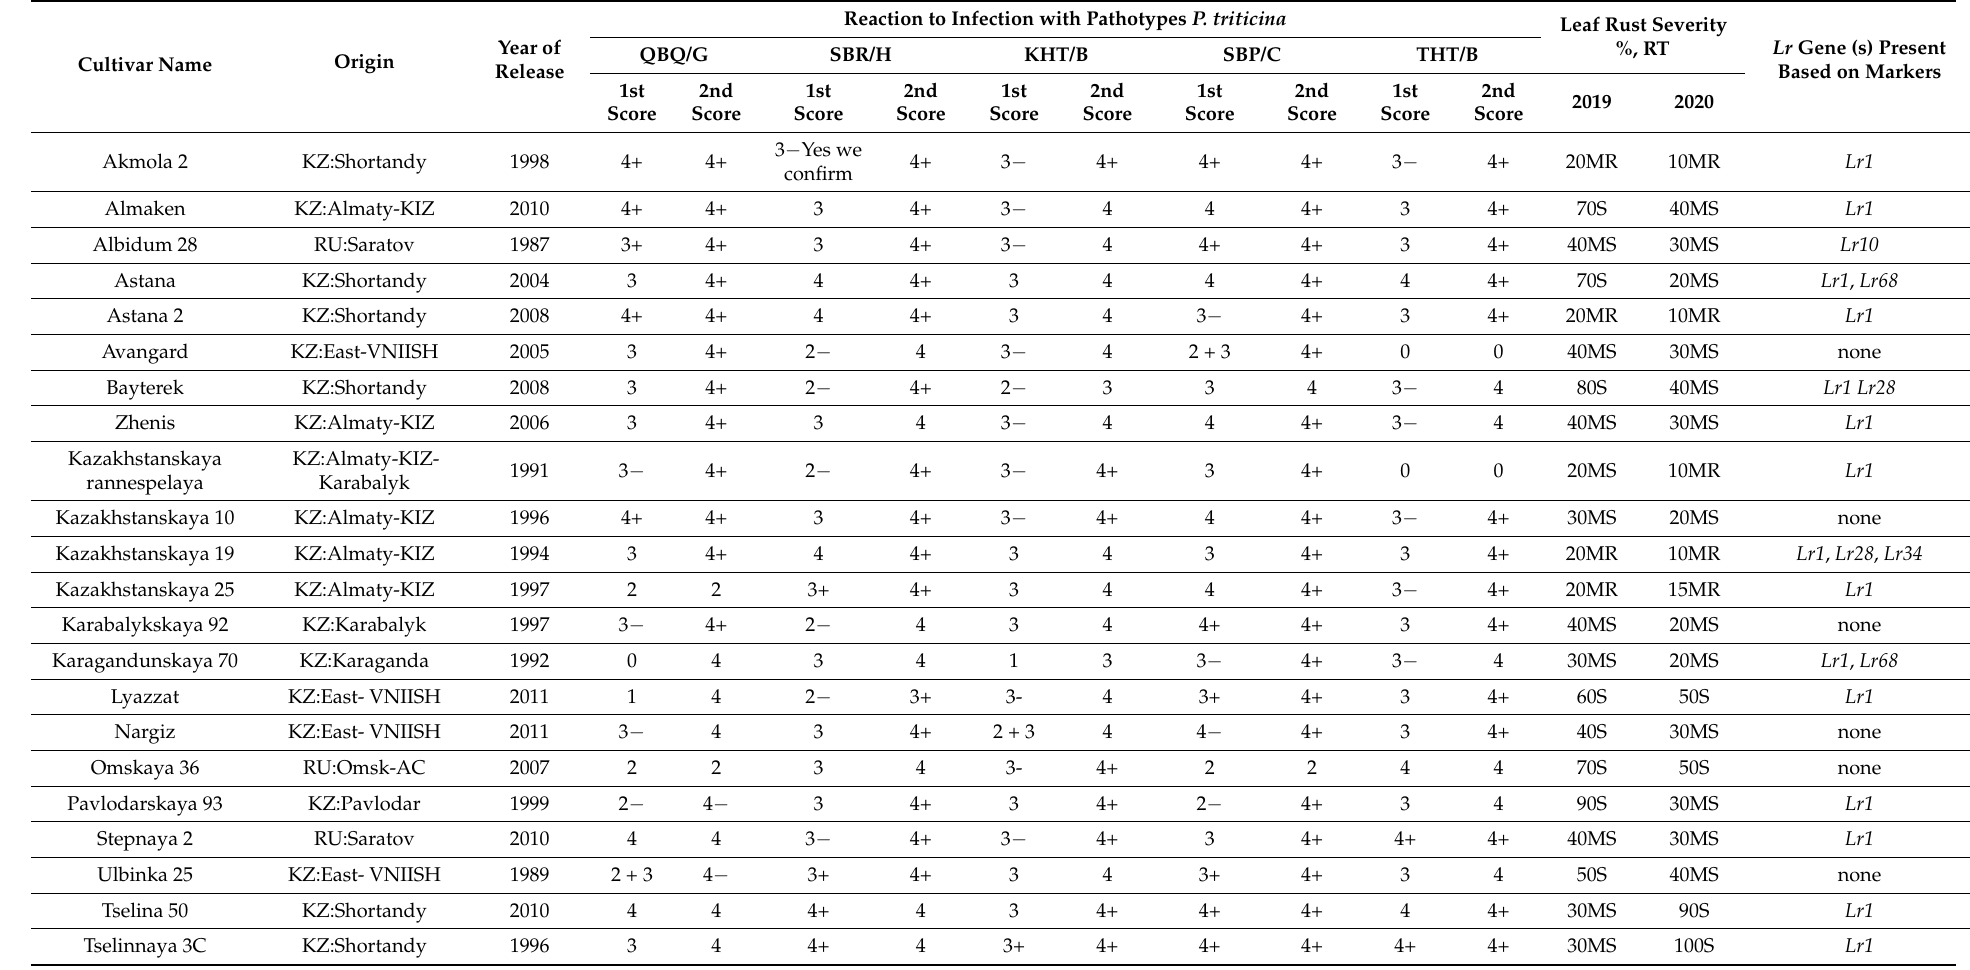
Table 2. The results of assessing spring wheat varieties to the pathotypes of P. triticina and identification of leaf rust resistance